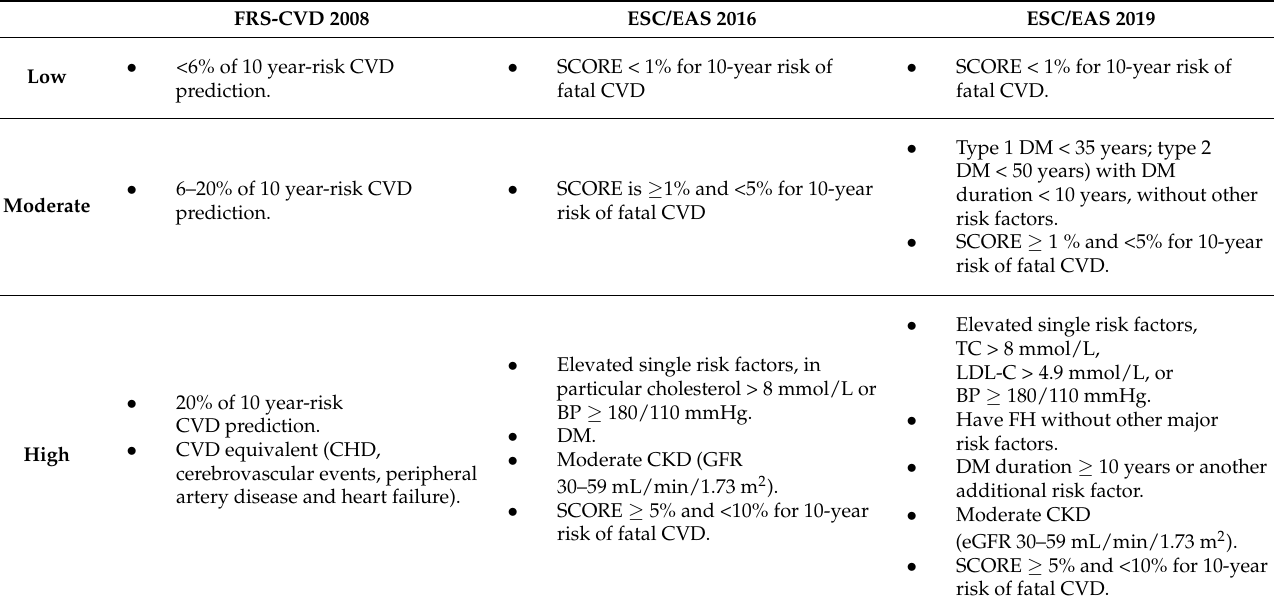
Summary of three cardiovascular disease risk scores, Framingham Risk Score— Cardiovascular Disease (FRS-CVD), European Society of Cardiology/European Atherosclerosis Society (ESC/EAS) 2016 and ESC/EAS 2019 Guidelines that were used to stratify the participants into low, moderate, high and very-high